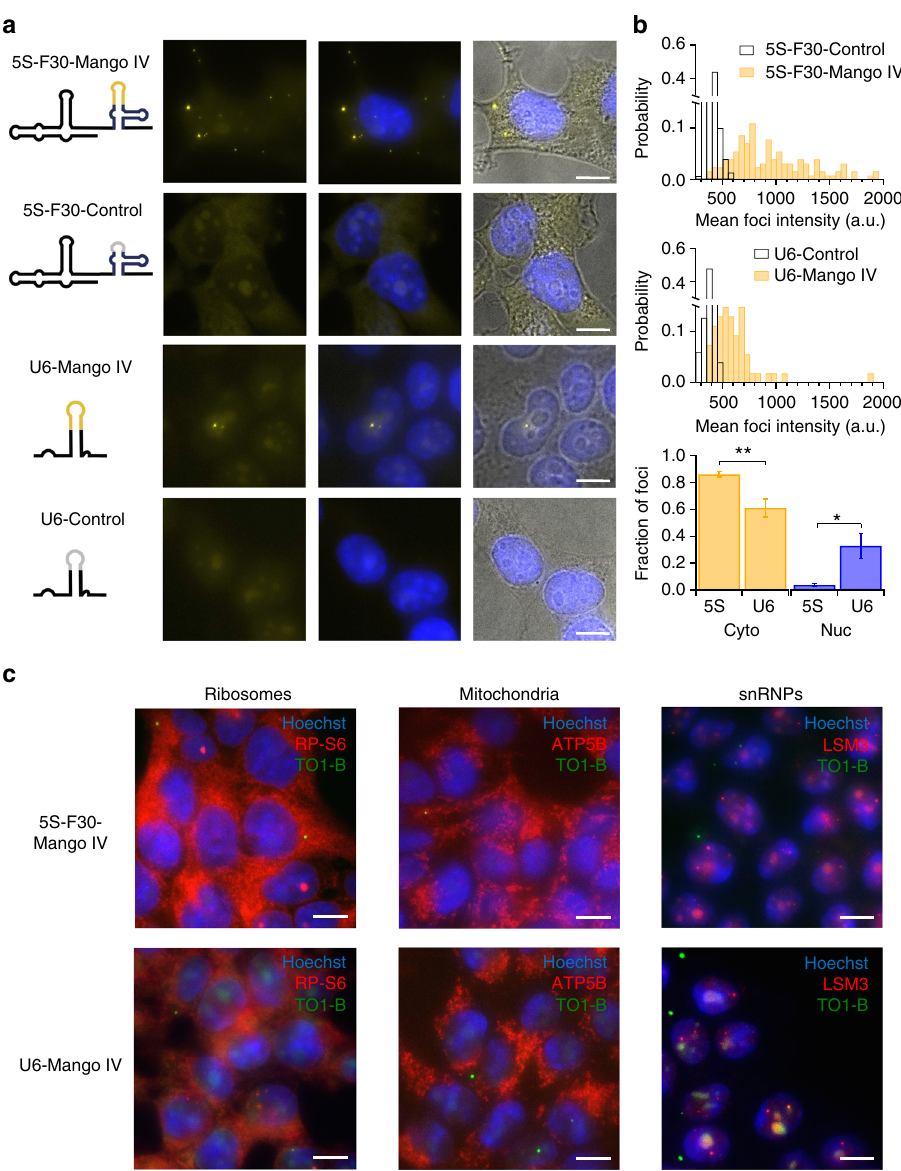
Fig. 4 Cellular imaging of Mango IV tagged RNAs. a Maximum projections of fi xed cells containing Mango IV tagged 5S and U6 RNAs stained with 200 nM TO1-B (yellow) and 1 µ g/mL Hoechst 33258 (blue) — construct diagrams shown as RNA-Mango (yellow) or non- fl uorescent control RNA (grey), F30 folding scaffold (blue) and remaining RNA sequence (black). b Mean intensity distributions of 5S-Mango IV and U6-Mango IV foci (yellow) compared to low intensity foci detected in control experiments (black). Fraction of foci observed in the cytoplasm and nucleus for 5S and U6-Mango IV RNAs (bottom panel, * p < 0.05 and ** p < 0.01 calculated using a t test). The number of cells for 5S-F30-Control, 5S-F30-Mango IV, U6-Control and U6-Mango IV were 57, 114, 131 and 183, respectively. Error bars depict standard error in the mean. c Localization of 5S-Mango IV and U6-Mango IV relative to immunostained ribosomes (RP-S6), mitochondria (ATP-5B) and snRNPs (LSm3). Scale bars are 10 μ m. All images are maximum projections except in c , which show